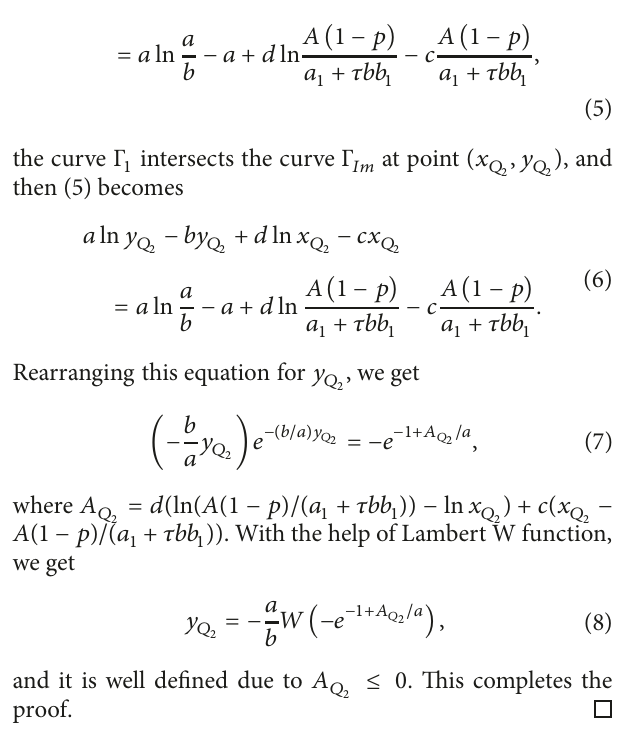
Figure 1: Illustration diagrams of the phase sets and impulsive sets for Cases (𝑖) and (𝑖𝑖) . (a) 𝐴/𝑎 1 ≤ 𝑥 ∗ ; (b) 𝑥 ∗ ≤ 𝐴/(𝑎 1 + 𝑎𝑏 1 ) and 𝑥 𝐸 𝐴(1 − 𝑝)/(𝑎 + 𝑏𝑏 𝜏) . Γ 1 1 1 is a trajectory touches the curve , 𝑦 ) 𝑆 = (𝑥 𝑆 𝑆